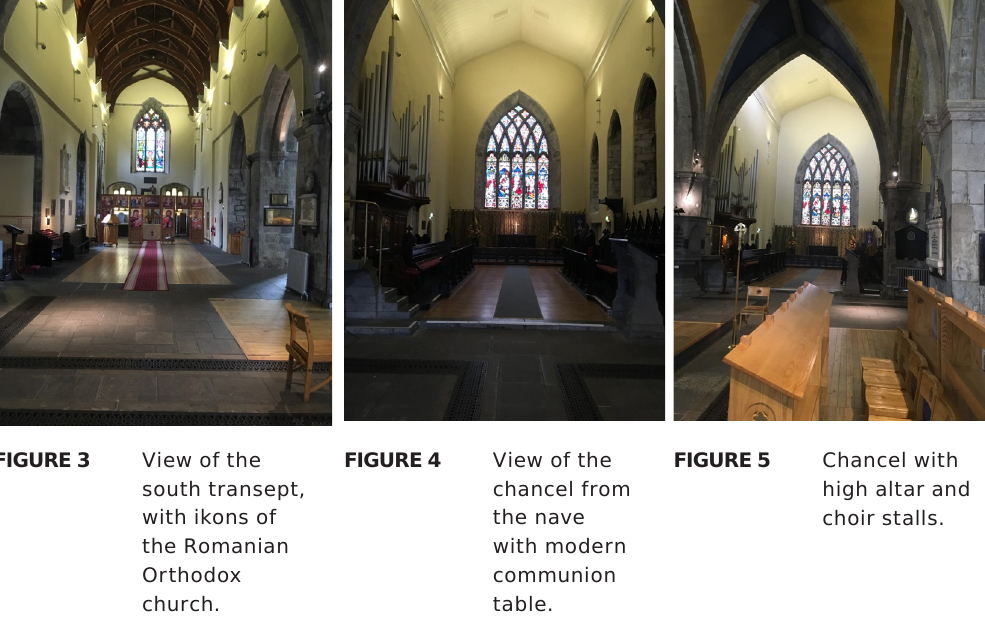
chancel from the nave with modern communion